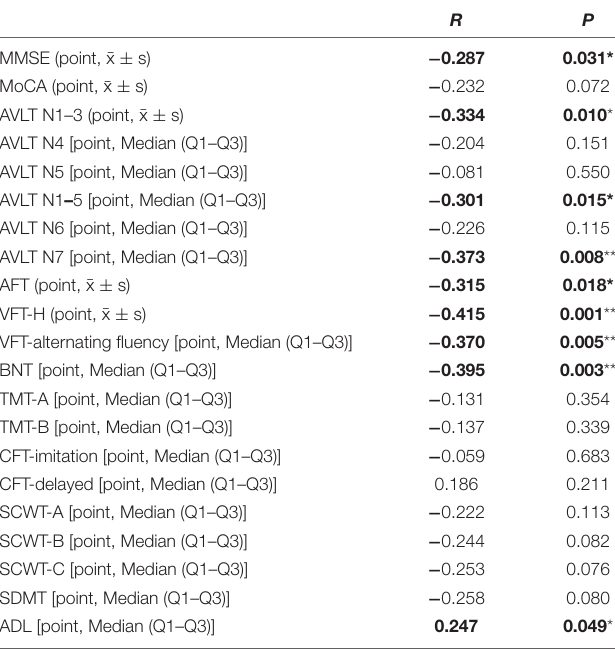
TABLE 3 | Correlations of pure tone audiometry (PTA) threshold with the scores of clinical symptoms from Alzheimer’s disease (AD) patients.